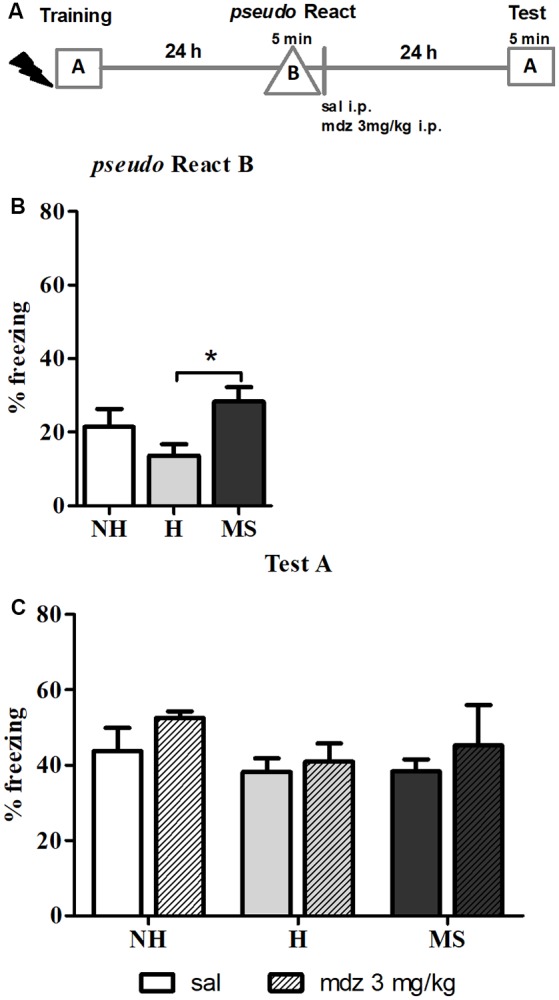
The effect of midazolam (mdz) injection after a pseudo-reactivation in context B was tested by re-exposure to context A, in adult male rats that were non-handled (NH) or subjected to handling (H) or maternal separation (MS) in the neonatal period. Mdz effect on reconsolidation is specific to reactivated memories. (A) Schematic diagram of the experimental design. (B) Freezing in context B, in the pseudo Reactivation (React) session, n = 15–17/group. (C) Freezing in context A, in the Test session, of animals that received either sal or mdz 3 mg/kg after the pseudo React B session, n = 7–9/group. Data are expressed as mean ± SEM, in percentage of total session duration. 2w-ANOVA was used for statistical analyses; *p < 0.05. Statistics results are presented in detail in subsections “MS Rats Generalize the Fear Response to Novel Environments” and “Mdz Disrupting Effect on Reconsolidation Requires Properly Reactivated Memories.”